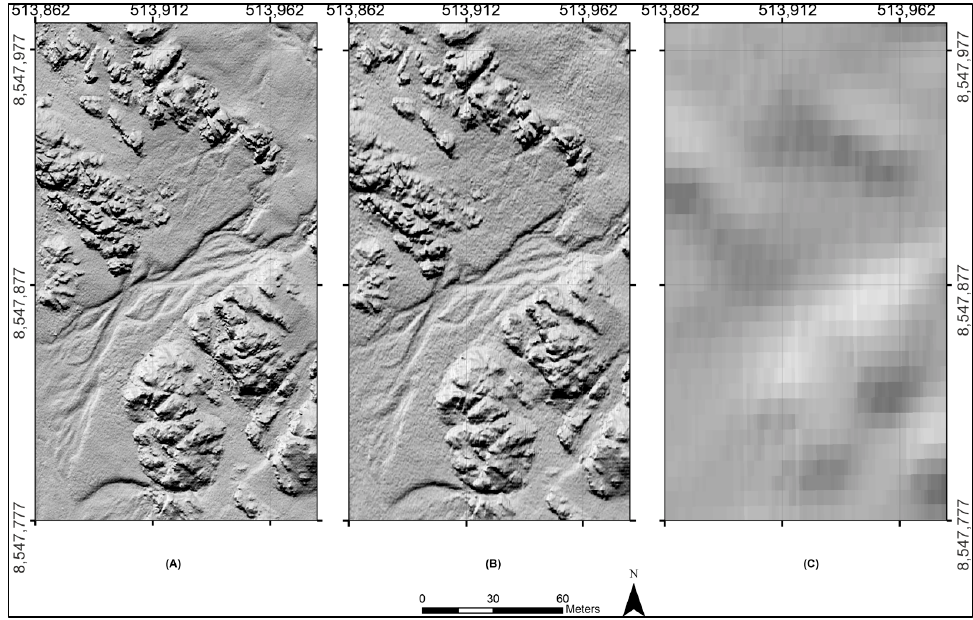
Figure 7. Comparison of the three different DEMs: ( A ) drone, ( B ) SIOS, and ( C ) Arctic in Fuglebekken (note the differences in smoother texture in the upper right corner on ( A ) and ( B )). Table 2. Comparison of features of different DEMs.